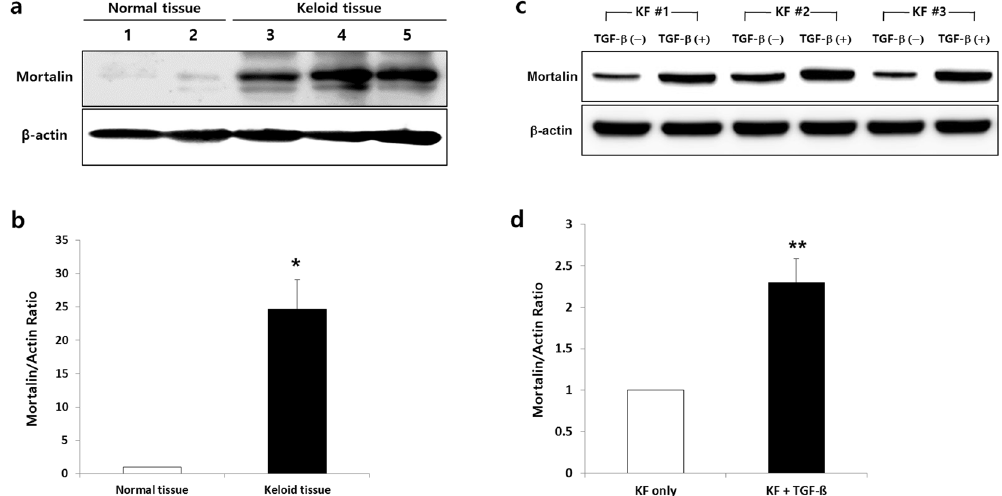
Figure 2. Expression of mortalin protein in keloid tissues by western blot. ( a & b ) The expression of mortalin protein was increased by 25 times on the keloid tissues compared to normal dermal tissues. ( c & s ) Also, mortalin protein expressions were more increased by 2.3 times on the activated KFs by TGF- β 1 (10 ng/mL).